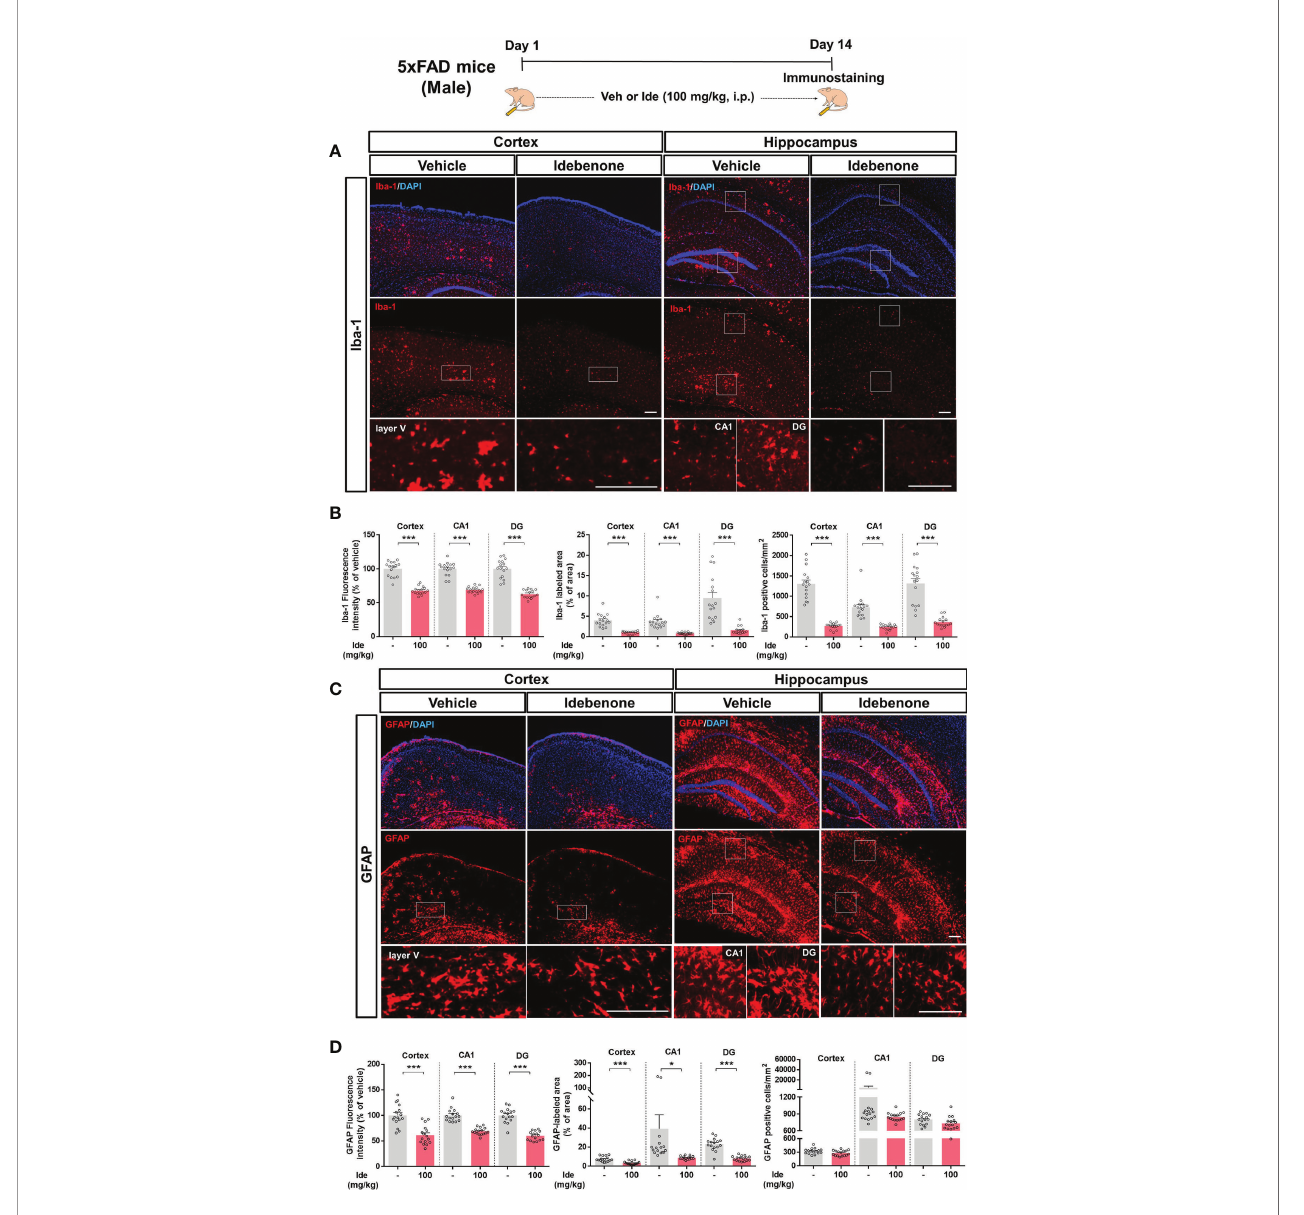
FIGURE 10 | Idebenone attenuates A b -associated micro/astrogliosis and micro/astroglial hyperplasia and proliferation in 5xFAD mice. (A, C) Representative images of Iba-1 and GFAP immuno fl uorescence in the cortex and hippocampus. Idebenone (100 mg/kg, i.p.) or vehicle was administered to 3-month-old 5xFAD mice daily for 14 consecutive days. After the last injection, the mice were sacri fi ced, and brain sections were immunostained with anti-Iba-1 or anti-GFAP antibodies. (B) Quanti fi cation of the fl uorescence intensity of Iba-1; Iba-1-immunolabeled area; and number of Iba-1-positive cells (n = 16 brain slices from 4 mice/group). (D) Quanti fi cation of the fl uorescence intensity of GFAP; GFAP-labeled area; and number of GFAP-positive cells (n = 16 brain slices from 4 mice/group). *p < 0.05 and ***p < 0.001. Scale bar = 200 m